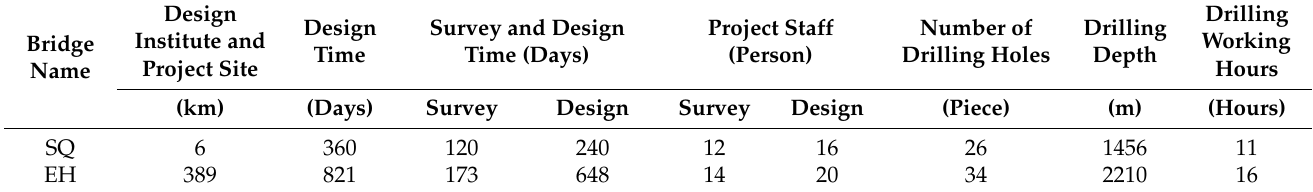
Table 1. Data summary table for the survey and design